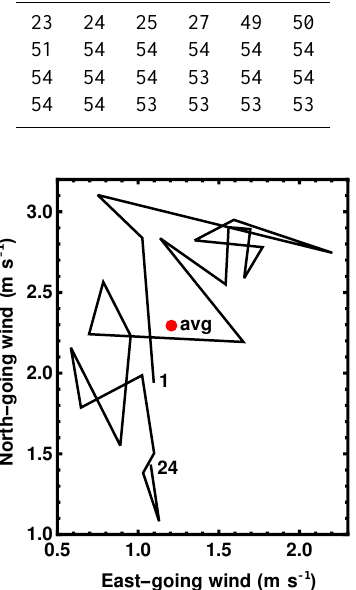
Figure 2. The measured wind velocity during the experiment at 20min intervals. The first and last measurements are labeled “1” and “24”, respectively, which represent 5 February 2015 from 13:00 to 21:00EST (local time). The average velocity is also given.